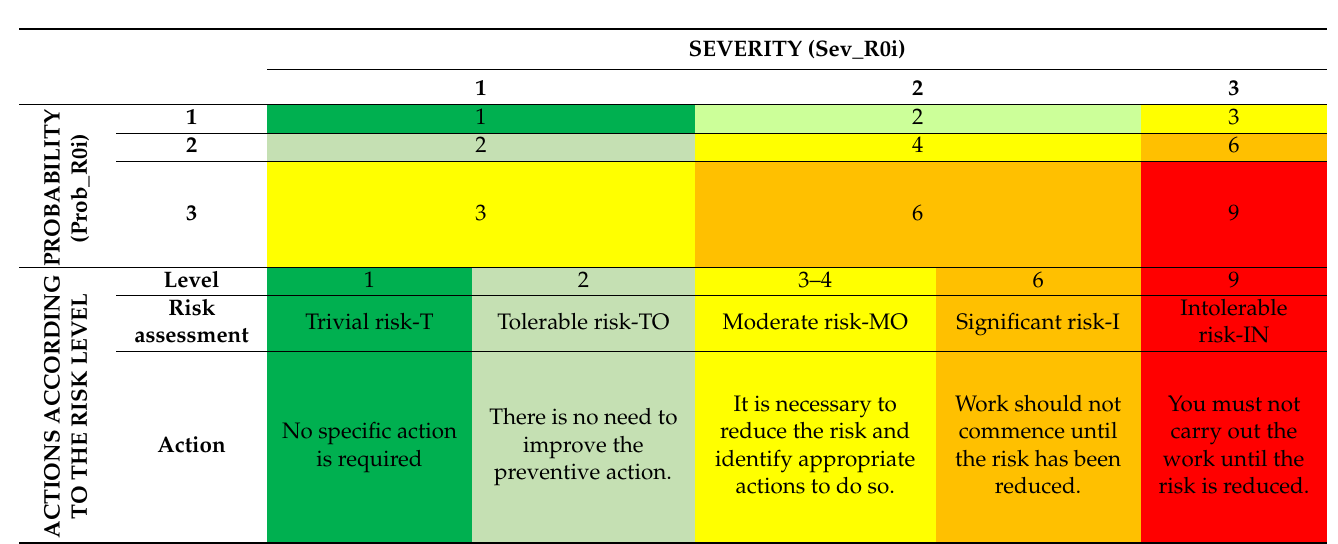
Table 1. Quantitative matrix of risk assessment in the BIM, adapted [66], and actions according to the risk